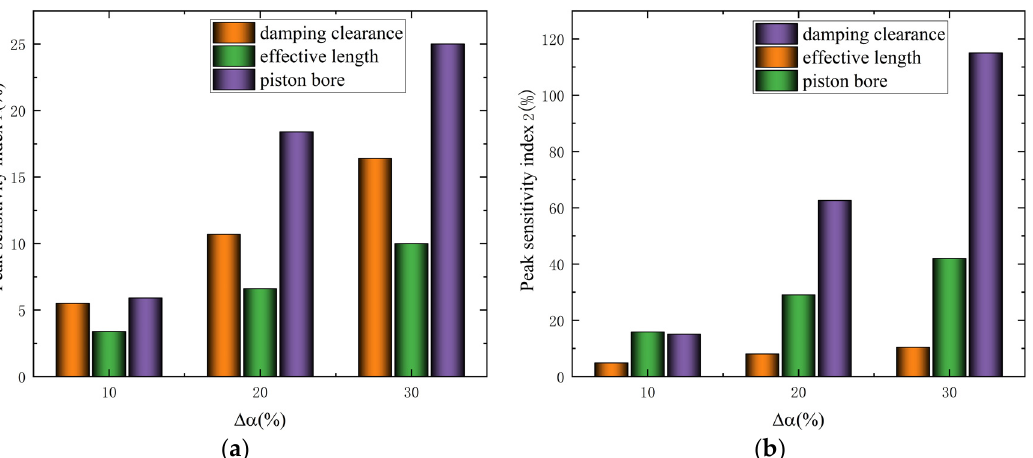
Figure 23. Peak sensitivity index of magnetic flux density and impact energy consumption. ( a ) Peak sensitivity index 1 (peak sensitivity index of magnetic induction intensity); ( b ) peak sensitivity index 2 (peak sensitivity index of impact energy consumption).